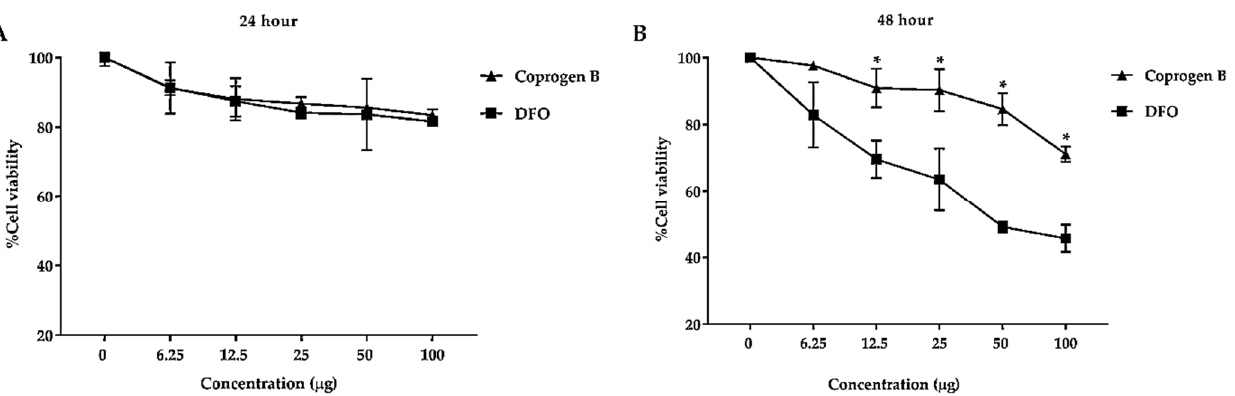
Figure 8. Investigation of the cytotoxic effect of coprogen B on human hepatocellular carcinoma cells. Viability of human hepatocellular carcinoma (Huh7) cells were treated with coprogen B ( ▲ ) and deferoxamine (DFO) ( ■ ) for 24 h ( A ) and 48 h ( B ). Data obtained from three independent triplicate experiments are expressed as mean ± SD. Asterisk (*) indicates significant difference (p -value < 0.0001) when compared between each concentration of coprogen B and DFO.